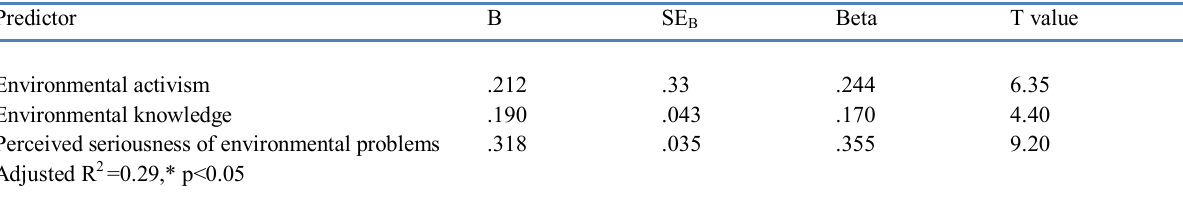
Table 4. Results of regression of independent variables on optional environmentally friendly buying behavior Predictor B SE B Beta T value Environmental activism Environmental knowledge Perceived seriousness of environmental problems Adjusted R 2 =0.29,*